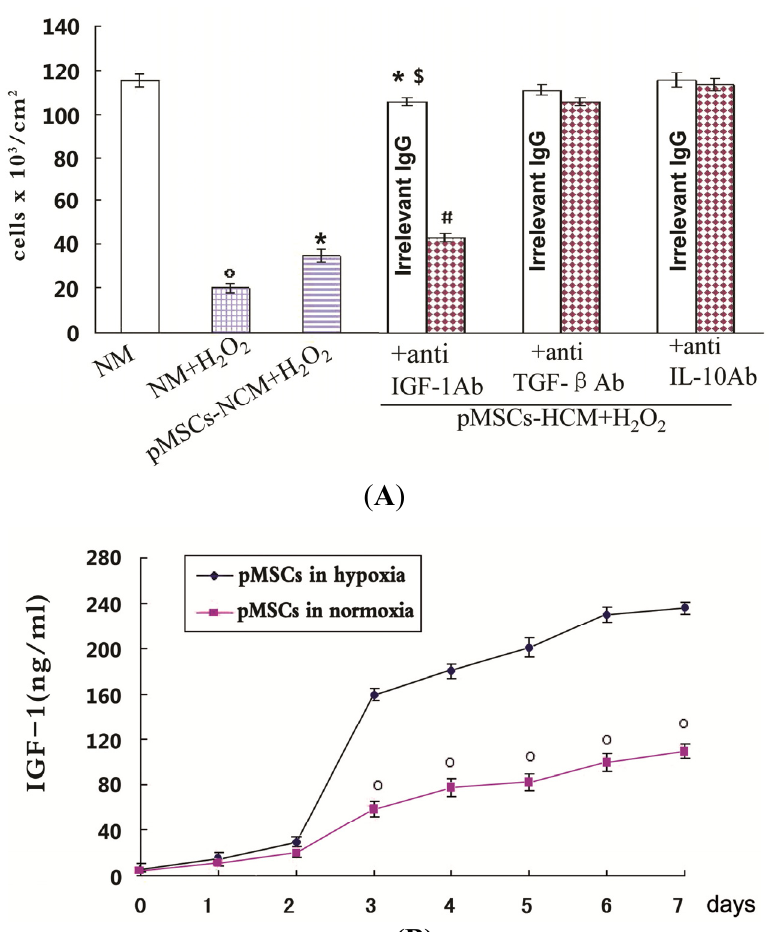
Figure 3. The pMSCs hypoxia culture mediums produce a better protective effect on caco2 cells from H O through more IGF-1. ( A ) Effect of anti-IGF-1, anti-TGF- β and 2 2 anti-IL-10 Ab on protective effect of pMSCs-HCM. Three hours after culturing H O -treated caco2 cells in pMSCs-HCM, cells were exposed to specific functional 2 2 blocking Ab against IGF-1, TGF β , L-10 or the corresponding irrelevant IgG. Cell count was evaluated after five days, º p < 0.05 versus NM; * p < 0.05 versus NM + H versus pMSCs-NCM + H O ; # p < 0.05 versus corresponding irrelevant IgG. ( n = 6); 2 2 ( B ) Hypoxia induced more IGF-1 secreted by pMSCs. The secretion of IGF-1 by pMSCs in both normoxia and hypoxia increased with time. There was no difference in the early two days. From the third day on, the secretion by pMSCs cultured in hypoxia was much higher than that in normoxia, and the difference persisted at seven days, º p < 0.05 versus pMSCs in hypoxia; and ( C ) Activated HIF-1 of pMSCs in hypoxia or normoxia measured by HIF-1 ELISA. pMSCs were cultured in hypoxia or normoxia for seven days and then the amount of activated HIF-1 was detected. Figure 3C shows mean amounts of activated HIF-1 normalized to amounts per million harvested cells. pMSCs in hypoxia have much more activated HIF-1 than that in normoxia; * p < 0.05 versus pMSCs in